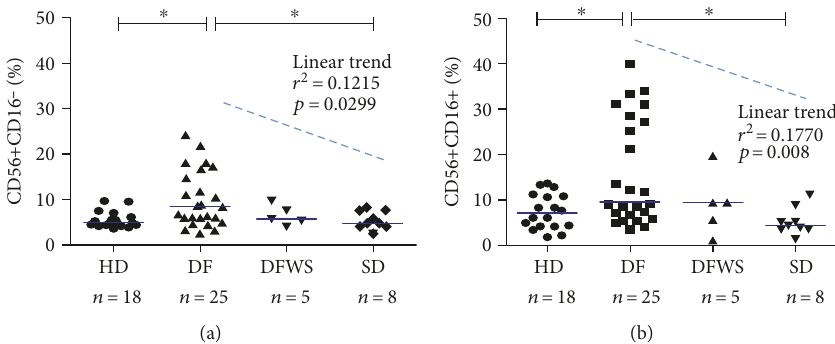
Figure 1: NK cell populations ’ frequency among dengue-infected patients. Patients ’ PBMCs collected during disease acute phase were phenotyped by CD56/CD16 cell surface density analysis by fl ow cytometry. Graphs represent median values (blue line) for NK subpopulation CD56+CD16 − (a) or CD56+CD16+ (b) frequencies among total PBMCs from patients or healthy donors (HD) in which each point represents one subject. Patients were ranked by severity: Dengue fever without warning signs (DF) or with warning signs (DFWS) and severe dengue (SD). Values were submitted to Mann – Whitney statistical test (for comparison between two groups in which ∗ p < 0 05 ) and one-way analysis of variance for linear tendency between group severity and analyzed